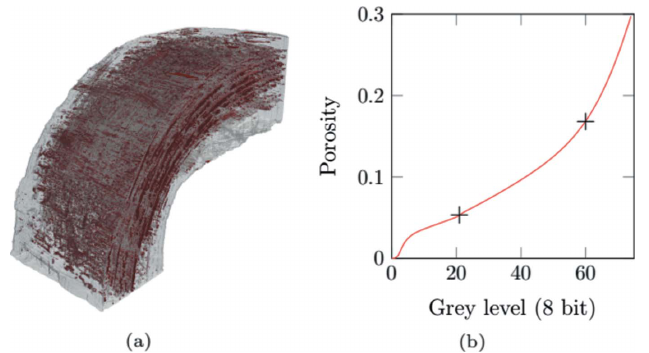
Figure 11 Porosity of the sample used for the high-temperature test. ( a ) Pore map (grey level threshold, 21). ( b ) Effect of the grey level threshold on the determined porosity. The two cross marks correspond to the chosen values for porosity taking into account SiC powder zones or not.